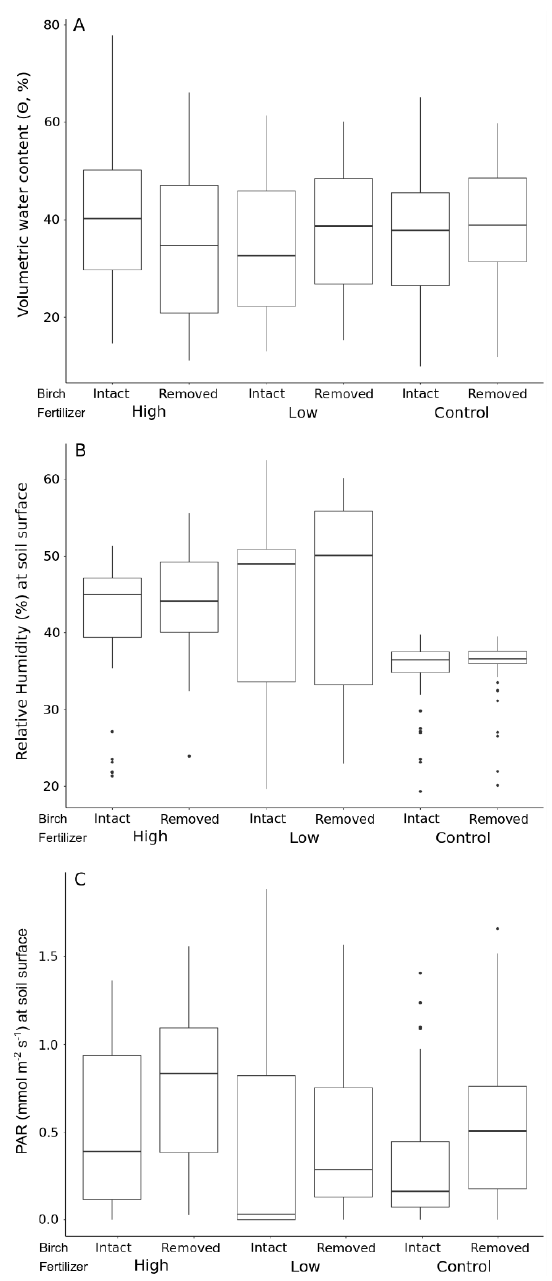
Figure 3. Volumetric water content ( Θ; A) was significantly increased by birch removal (p < 0.001). Relative humidity (RH; B) at ground level varied significantly with fertilizer dose and there was a significant interaction between birch removal and fertilizer dose (p < 0.001); RH is not different between birch-removed and intact plots, except for low fertilizer dose, where RH is higher where birch was removed. PAR (C) at ground level was significantly higher following birch removal and there was a significant interaction between birch removal and fertilizer doses, with fertilized birch removal plots showing the highest median values (p <